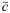
Rating and marking bar charts for Cannock Chase 2012 and Craigvinean 2015/2 as a result of low thinning experiments.The bars of the rater bar charts were ranked according to rating activity. r–number of raters, n–number of trees, κF –Fleiss’ kappa, rv−coefficient of variation of the proportions of the rater bar chart, c¯–mean conformity number, P0–proportion of trees marked “0” by all raters, Pm−proportion of trees marked in the 20% highest classes of the marking bar chart, see Section “Statistical measures of interrater agreement”.